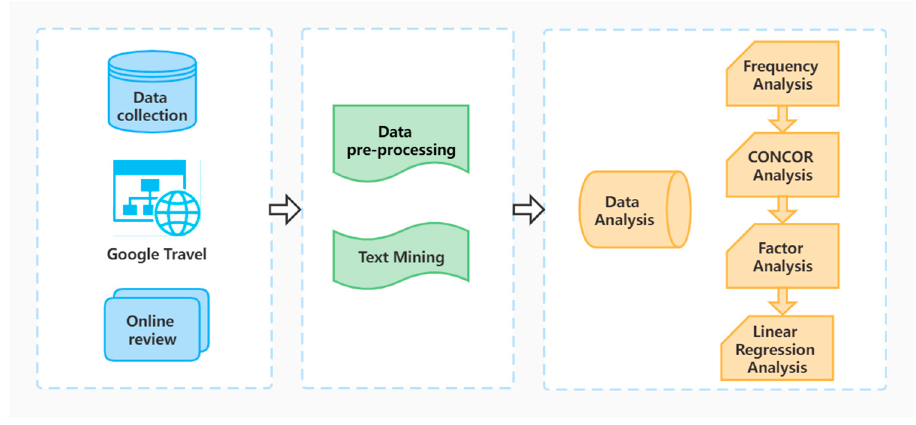
Figure 1. Research process.